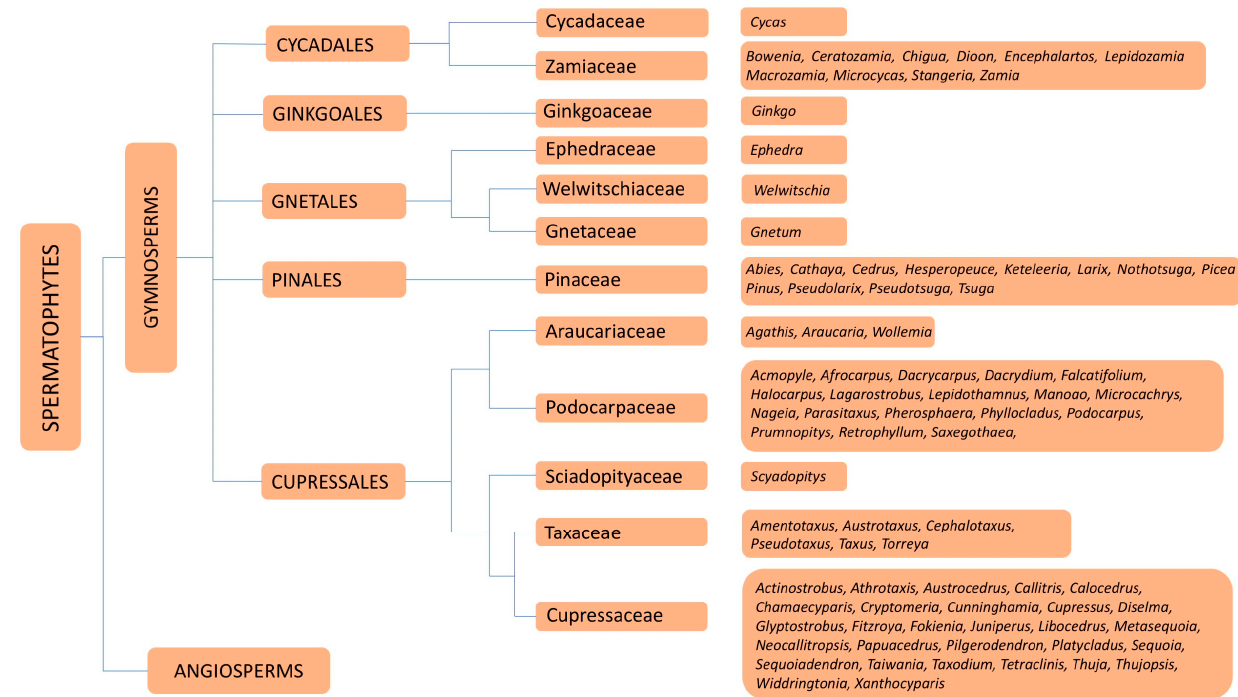
Figure 1. Gymnosperm tree based on molecular phylogeny data of tracheophytes [1].